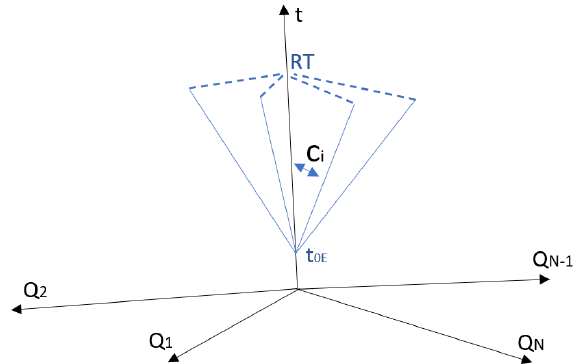
Figure 4. Linear hypothesis of Q N (t), (t 0E : time of occurrence of the earthquake E, RT: the repair time, Q i (t): recovery functions, t: time).